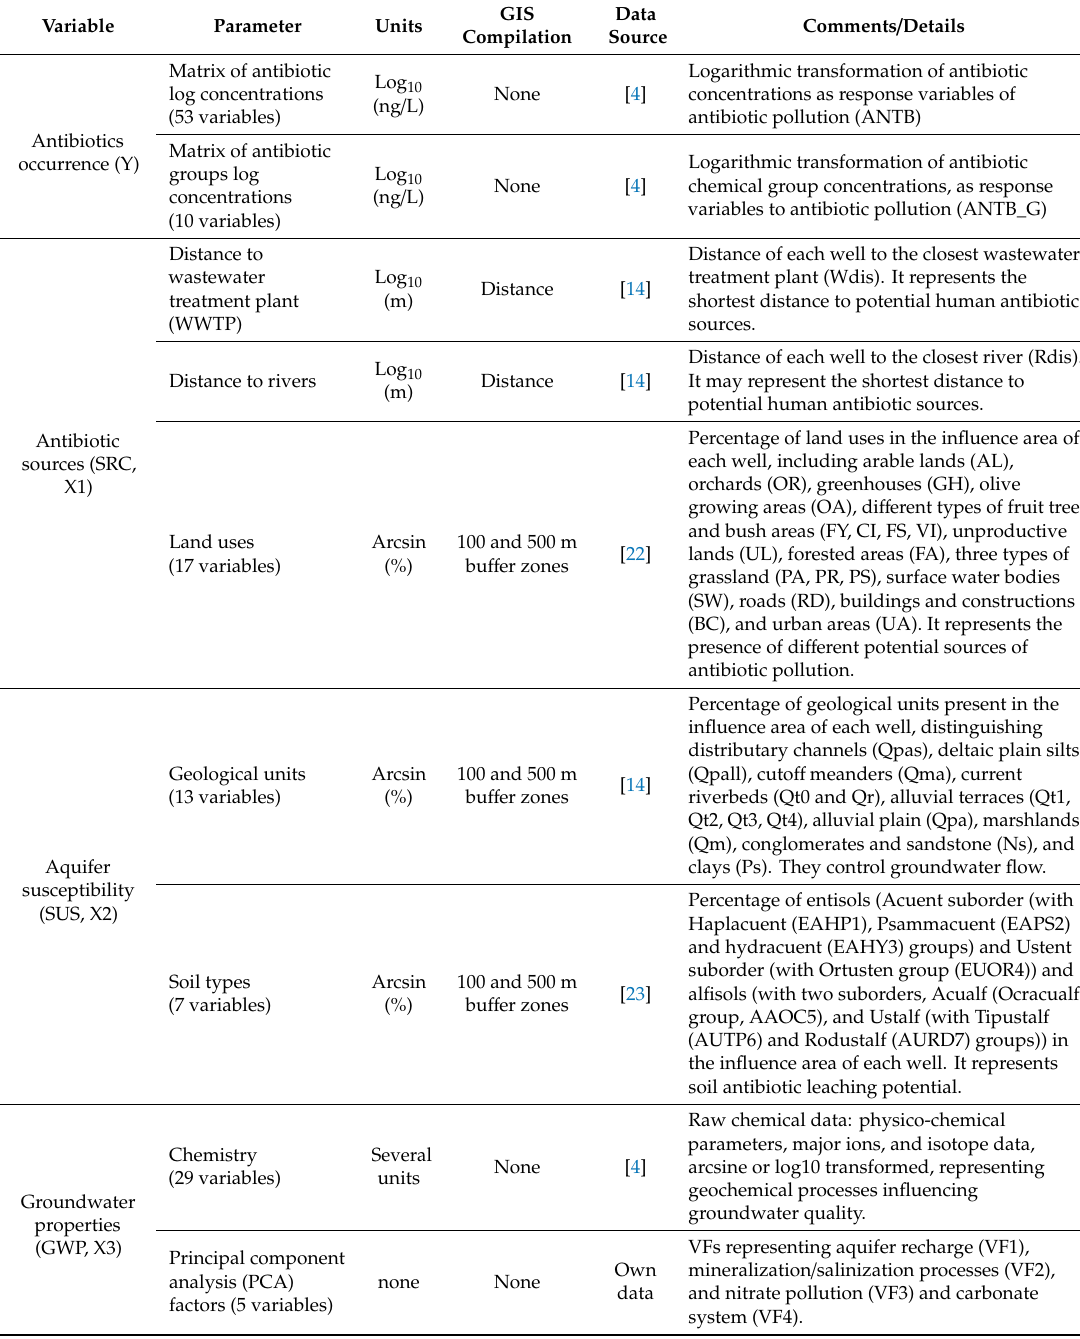
Table 1. Explanatory variables screened in the statistical